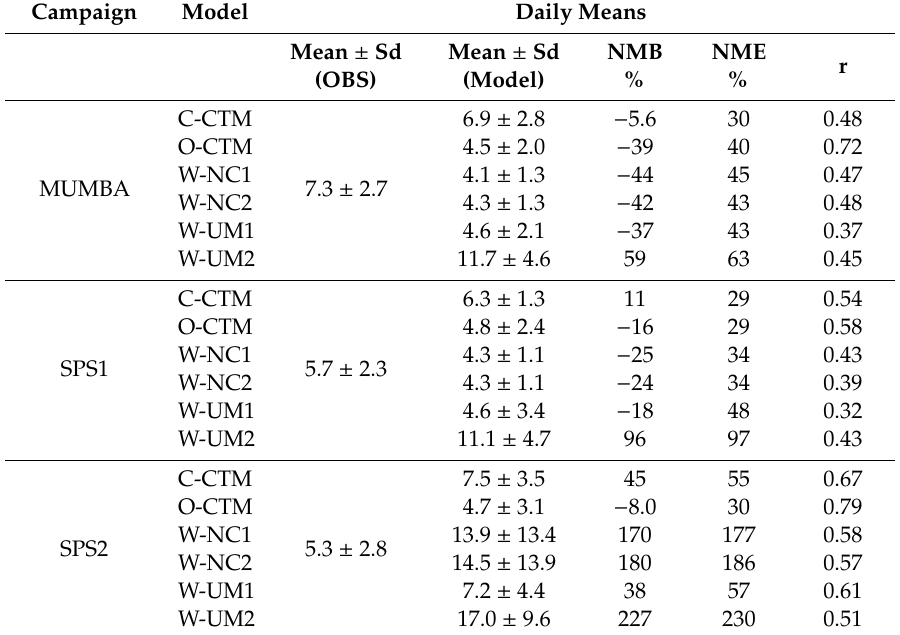
Table 3. Summary statistics for daily PM 2.5 concentrations in µ gm − 3 are listed for each model and each campaign including mean and standard deviation (Sd); normalized mean bias (NMB); normalized mean error (NME) and correlation coe ffi cient